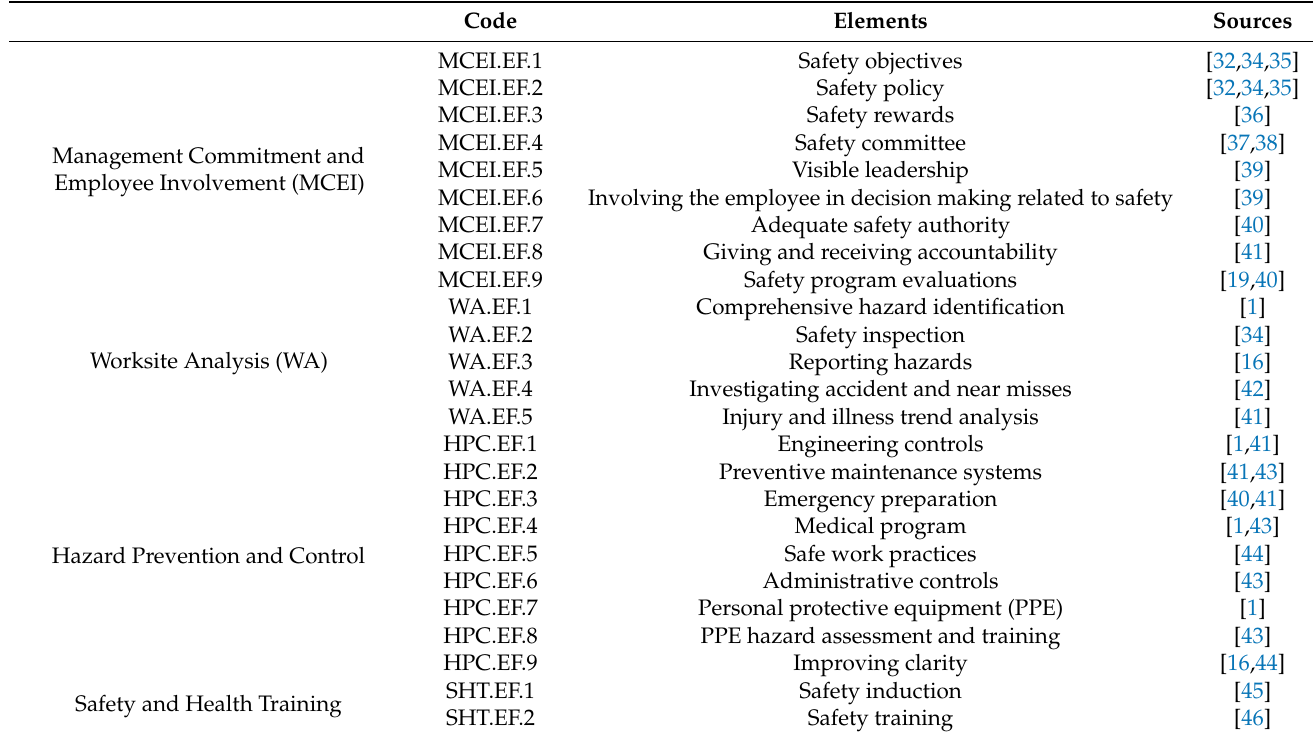
Table 1. Safety program